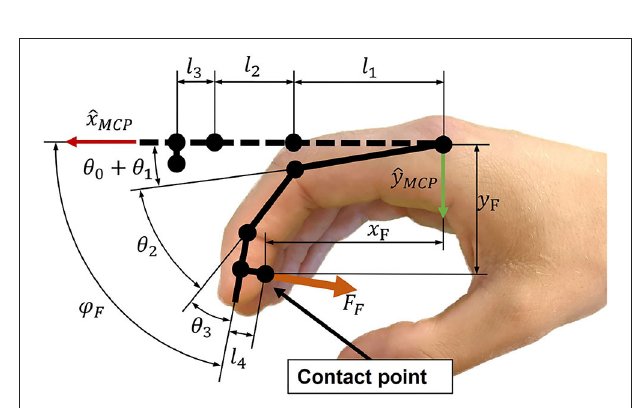
FIGURE 3 | Schematic representation of the index finger kinematics.